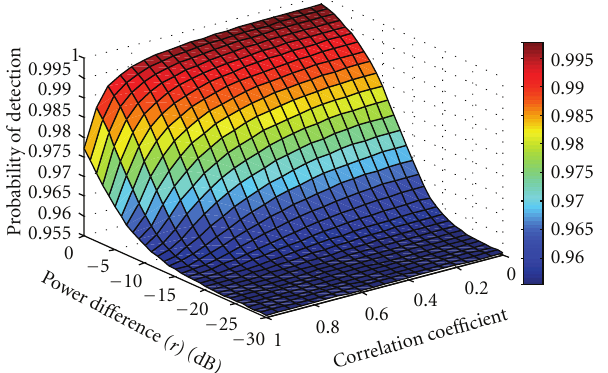
Figure 3: P D for P FA = 0 . 01 for the EC combiner versus correlation coe ffi cient and power di ff erence between diversity branches.